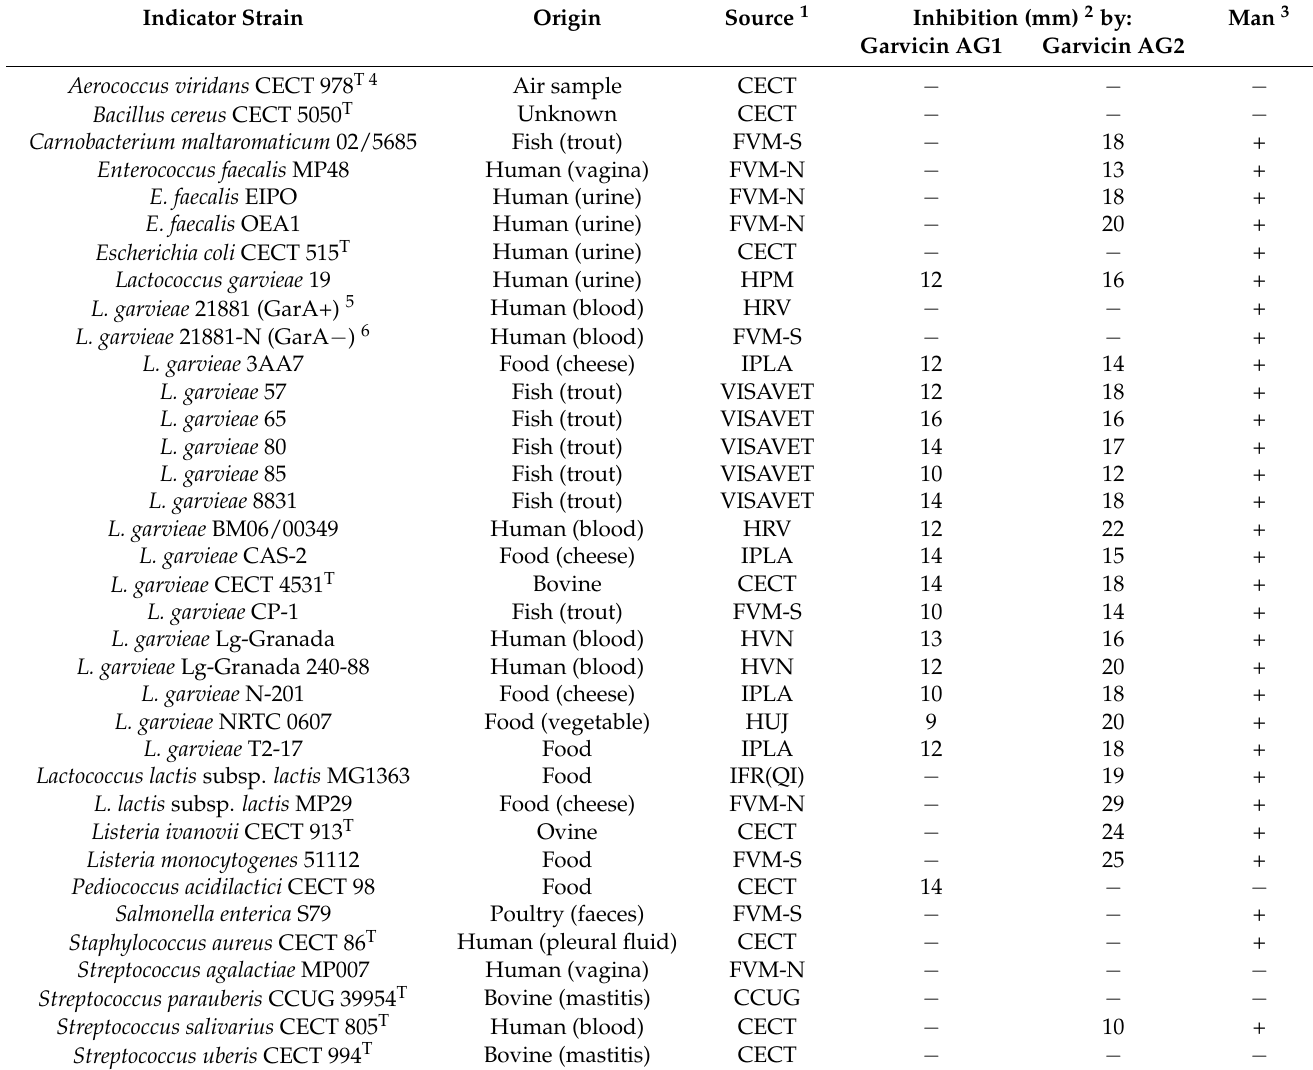
Table 1. Antimicrobial spectrum of garvicins AG1 and AG2, as well as the mannose-fermenting ability of the indicator